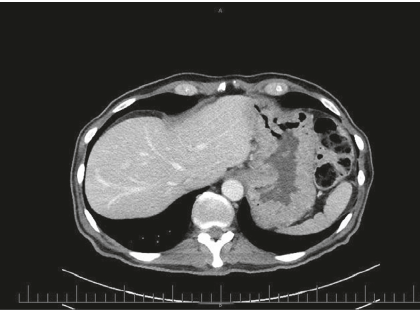
Figure 3: Abdominal CT on admission demonstrating hypertro- phic gastric